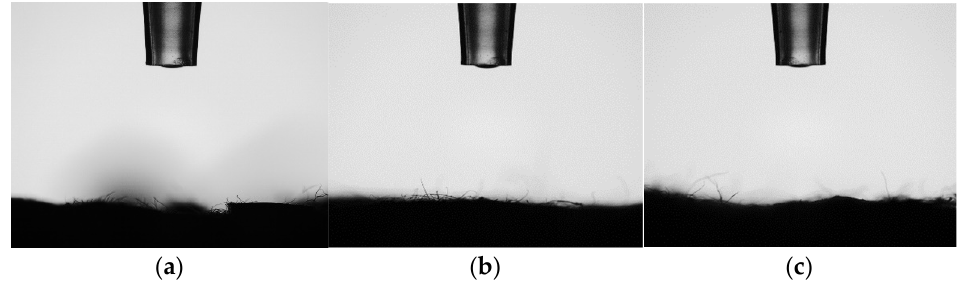
( c ) Figure 7. Cellulose fibers extracted with different conditions resulting from the steam-explosion process (Step2). ( a ) 15 min, ( b ) 25 min, ( c ) 33 min. Furthermore, the hydrophobicity of the extracted fibers was analyzed by contact an- gle measurements with double distilled water as the standard liquid. The results obtained from the static contact angle showed that water droplets are instantaneously absorbed by the isolated cellulose fibers obtained at different steam-explosion process times. There- fore, the contact angle of the isolated cellulose fibers is zero, as shown in Figure 8. The